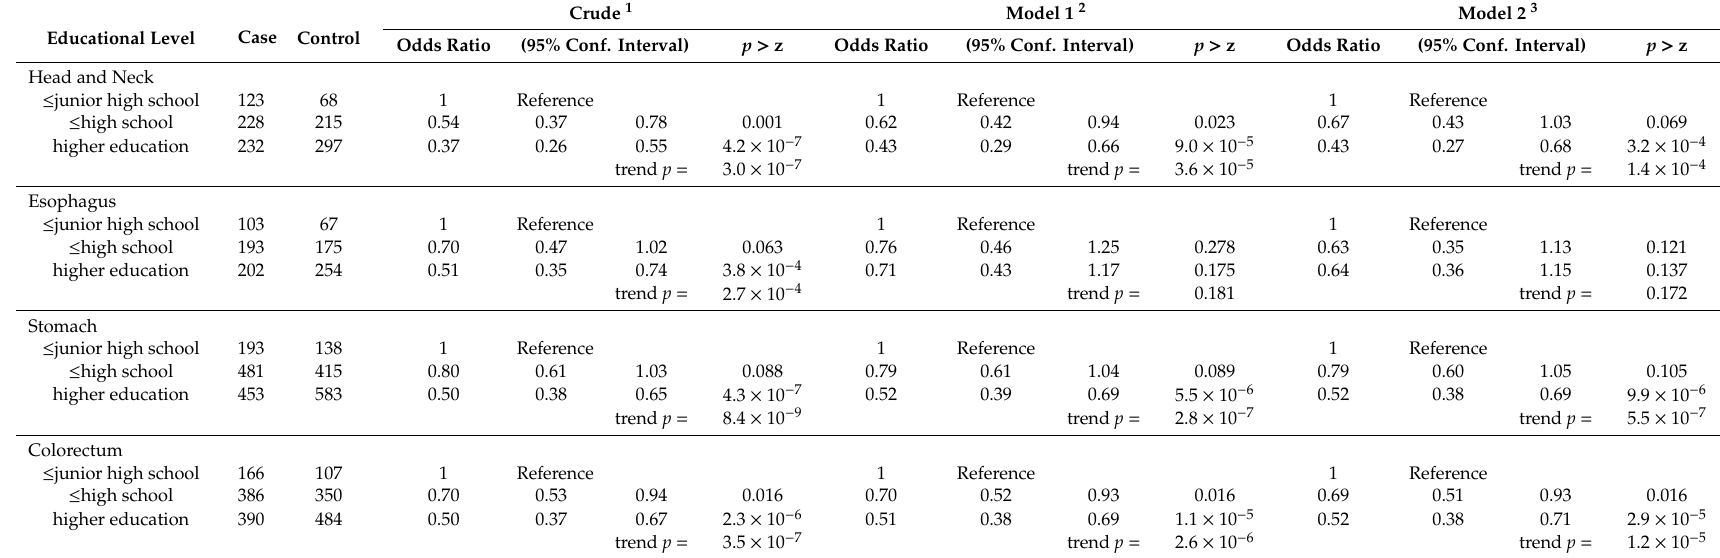
Table 2. Association between educational level and risk of subject cancers by site 4